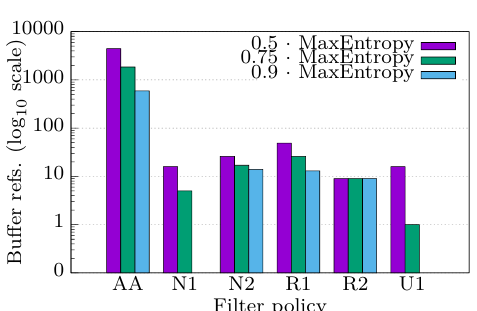
Figure 8: Number of key buffers to analyze. AA: initial database; Nn, Rn, Un: database after processing a trace with references kept if referenced by a block in the trace.